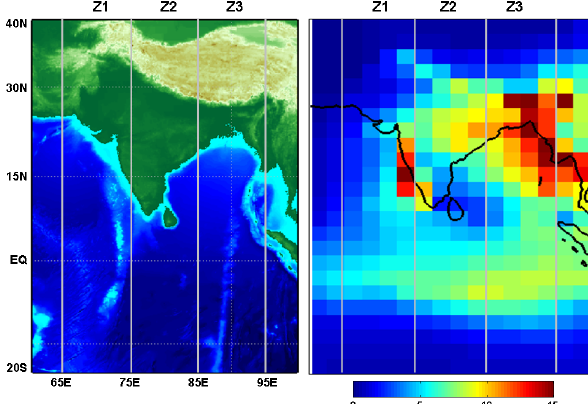
Figure 3. The study area and three selected zones (left panel) and climatological distribution of rainfall (mmday − 1 , right panel) for summer monsoon (JJAS) obtained from the Global Precipita- tion Climatology Project Version 2.2 monthly data (Huffman et al.,